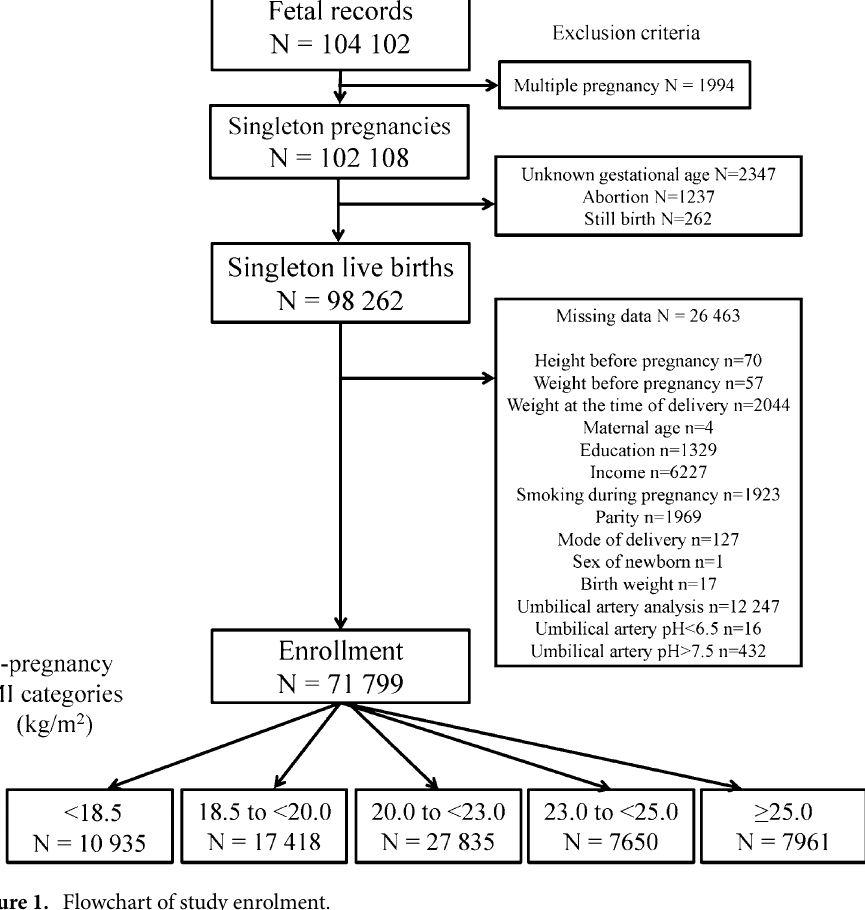
Figure 1. Flowchart of study